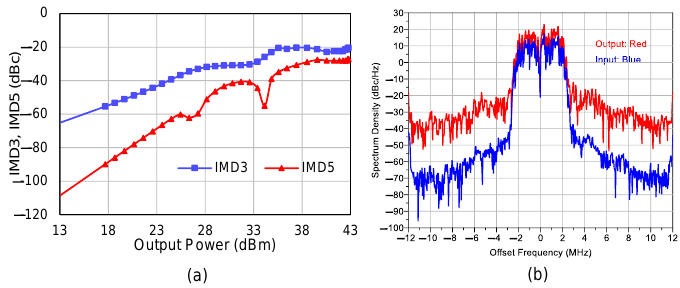
Figure 7. ( a ) Simulated IMD3 and IMD5 versus output power. ( b ) Simulated input (blue) and output (red) spectra at 3.5GHz.